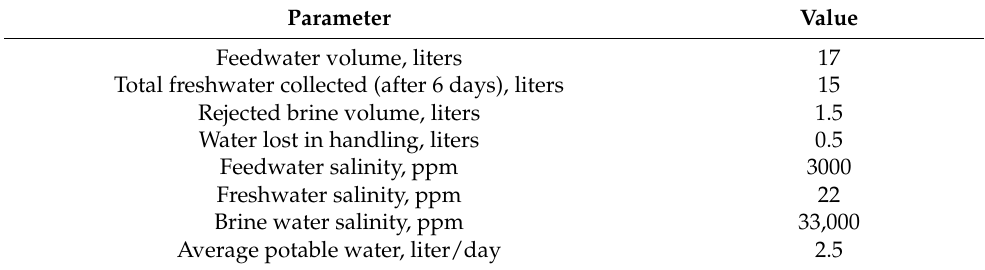
Table 1. Operational data.